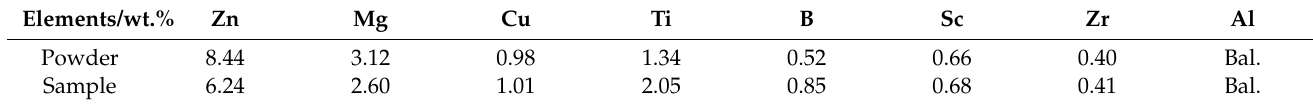
Table 2. The composition of micron-sized TiB 2 /AlZnMgCu(Sc,Zr) powder and the formed sample.